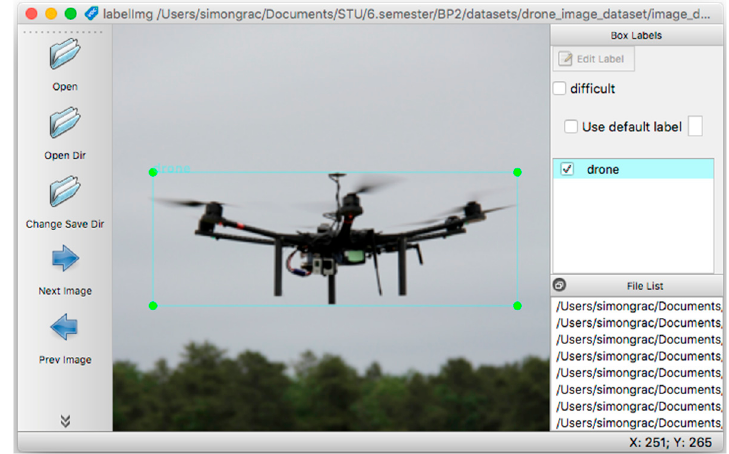
Figure 13. Annotated object (drone) in LabelImg.